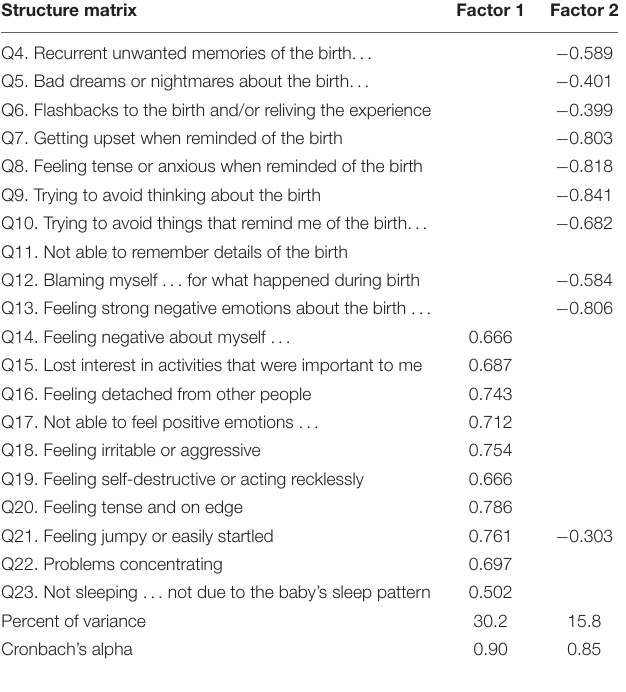
TABLE 3 | Factor solution of